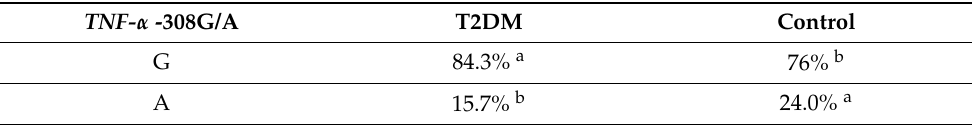
Table 4. Frequency of TNF- α -308G/A alleles in T2DM and control groups. TNF- α -308G/A T2DM Control 84.3%